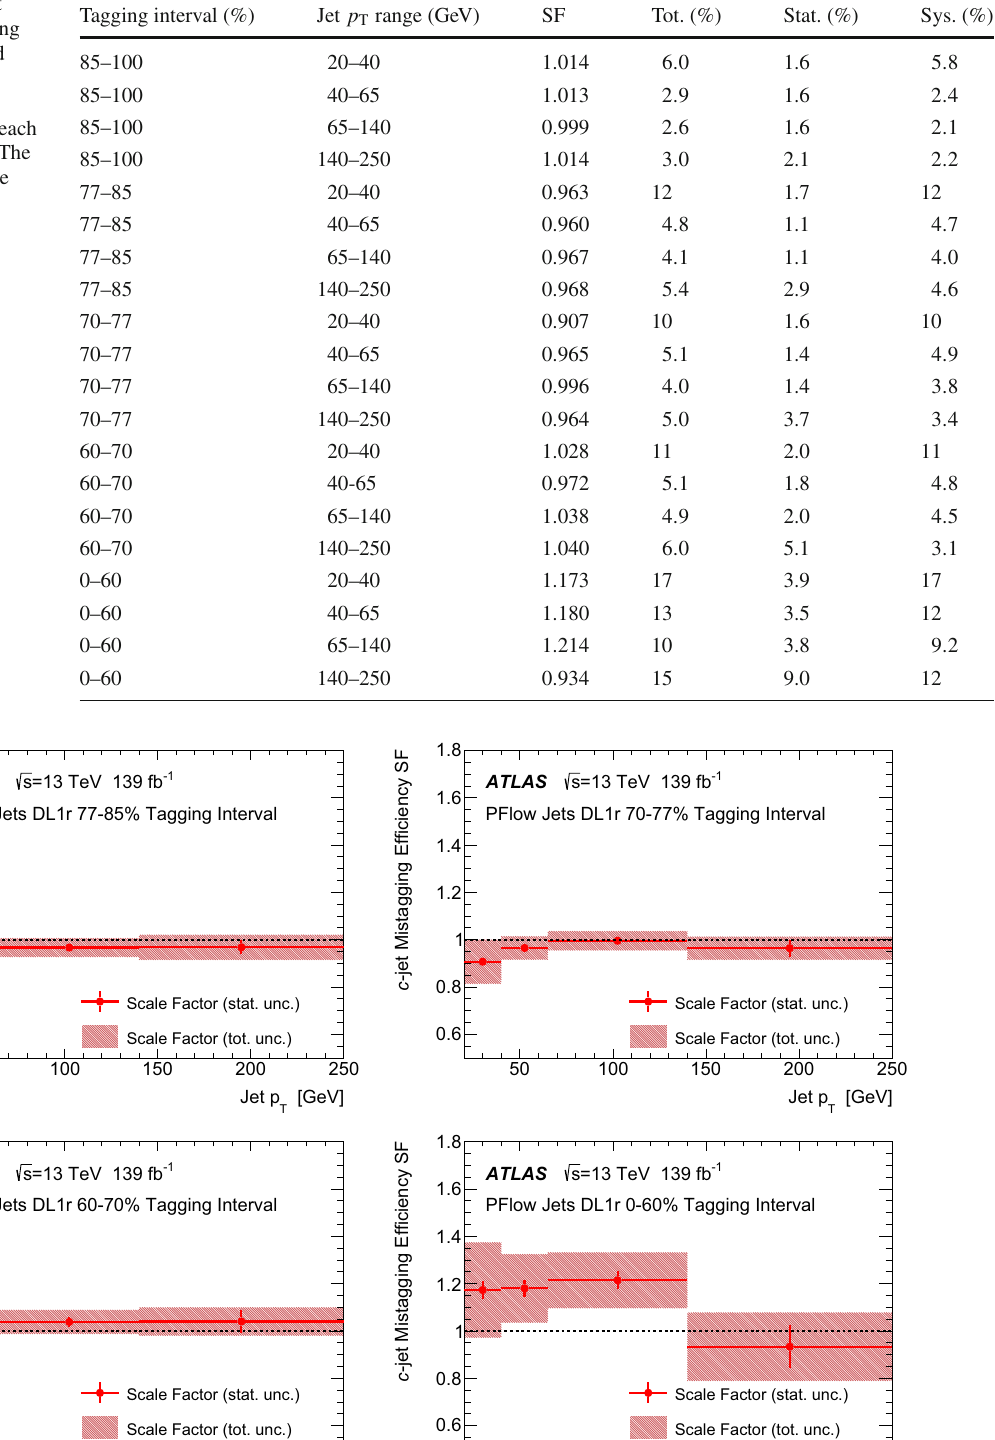
Table 1 The measured c -jet pseudo-continuous mistagging efficiency scale factors listed with the total, statistical and systematic uncertainties for particle-flow jets shown for each tagging and jet- p T interval. The scale factors are listed for the Pythia 8+ EvtGen fragmentation model